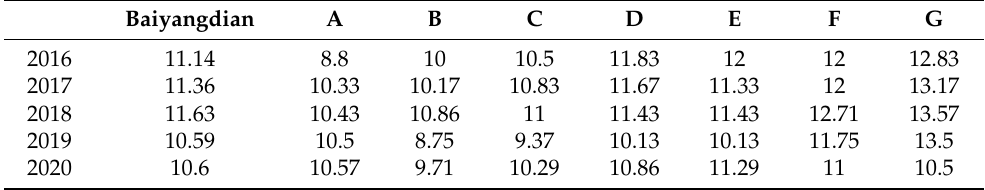
Figure 8. Mean annual FUI values of Baiyangdian Lake and its seven sub-regions in 2016–2020. Table 2. The statistical results of mean annual FUI values of the Baiyangdian Lake and seven